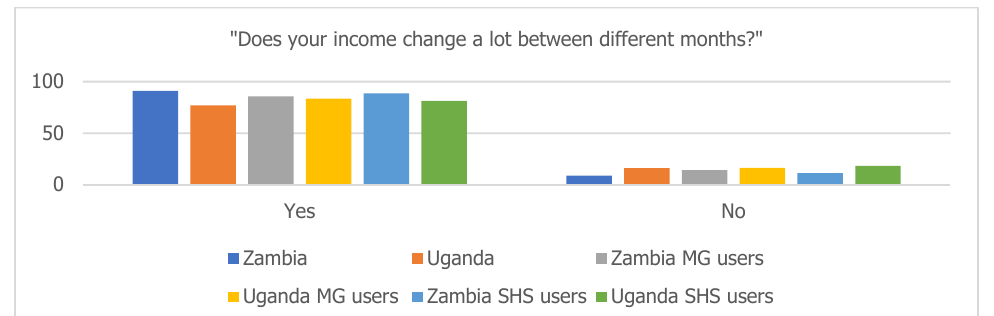
Figure A1. Income intermittency in Uganda and Zambia (N = 1016; Responses in %; Multiple responses possible).